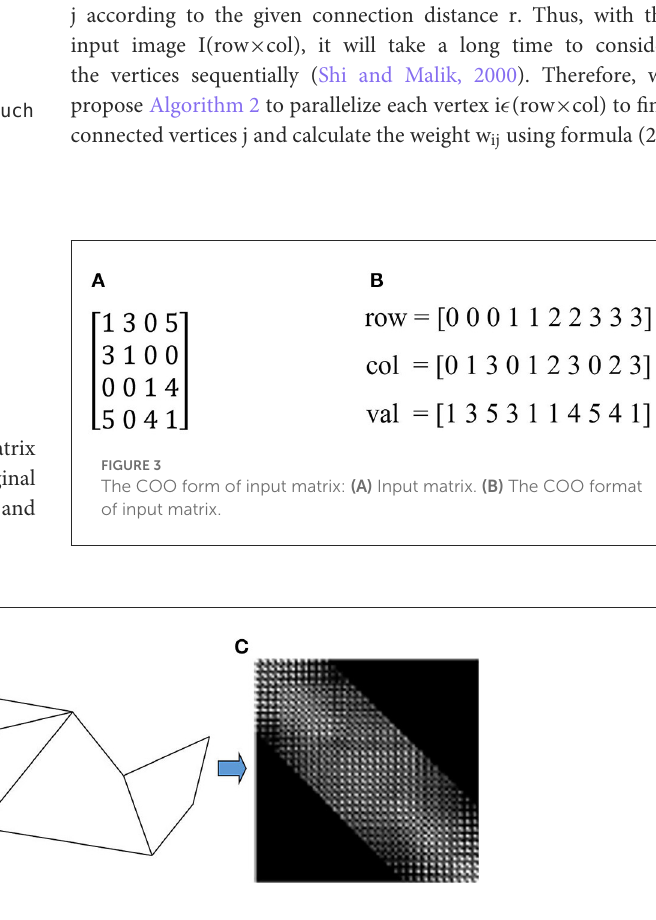
FrontiersinBigData